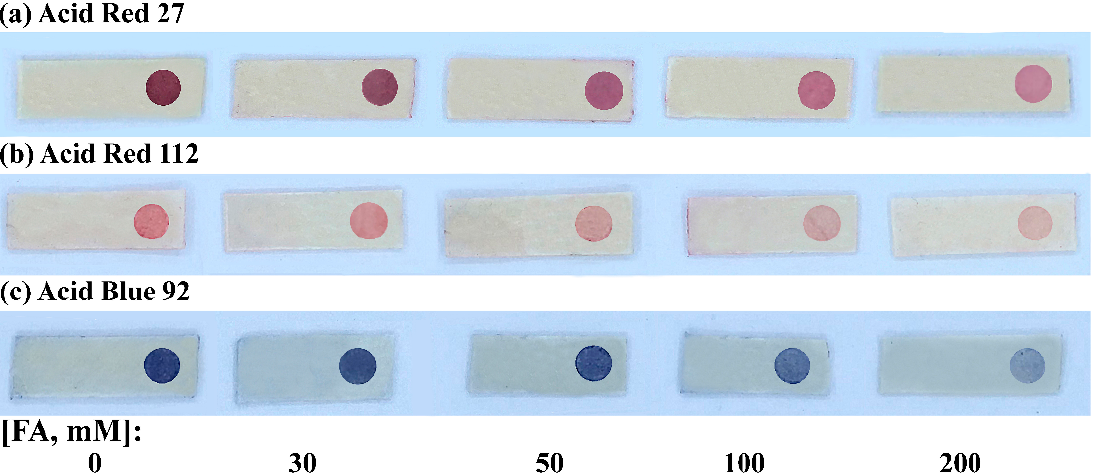
Figure 2. Sensor platforms immobilized with: ( a ) Acid Red 27, ( b ) Acid Red 112, and ( c ) Acid Blue 92, treated with FA.